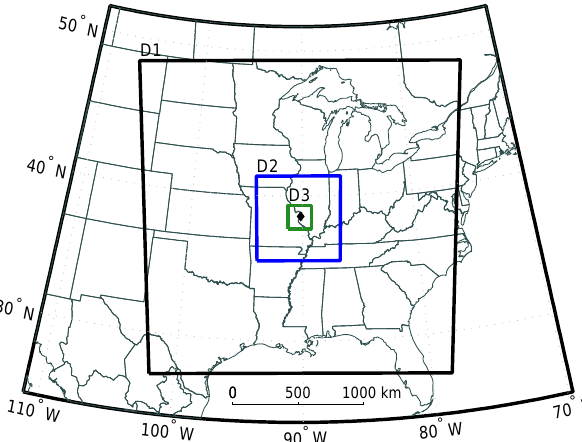
Figure 1. Domains used for the WRF simulations: large (D1, 27km resolution), Regional (D2, 9km resolution) and Local (D3, 3km resolution). CAMx simulations are performed on the Regional and Local domains, except for open burning which are performed on the Large and the Regional domains. The diamond shows the location of the St. Louis–Midwest